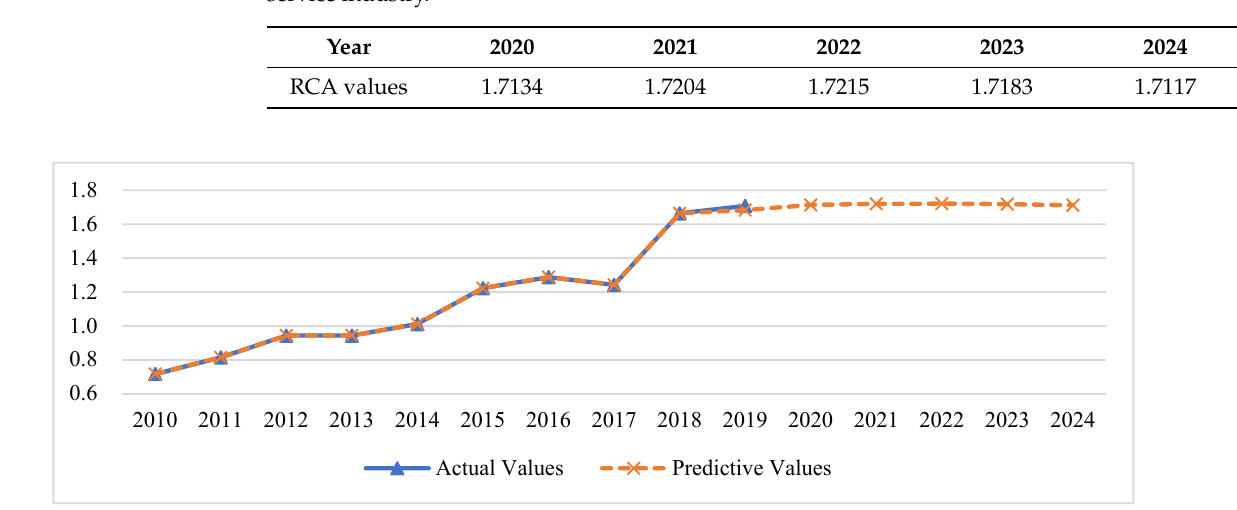
Figure 3. Actual and predictive values of international competitiveness of China’s computer information service industry.